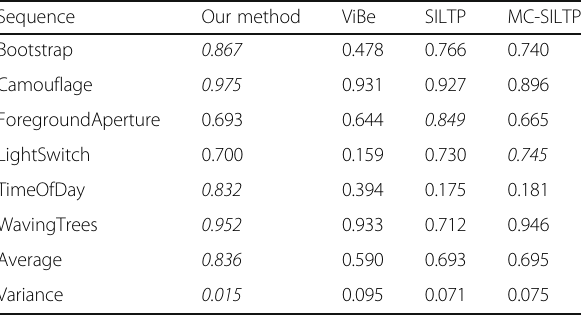
Table 1 F1 results on the Wallflower dataset Sequence